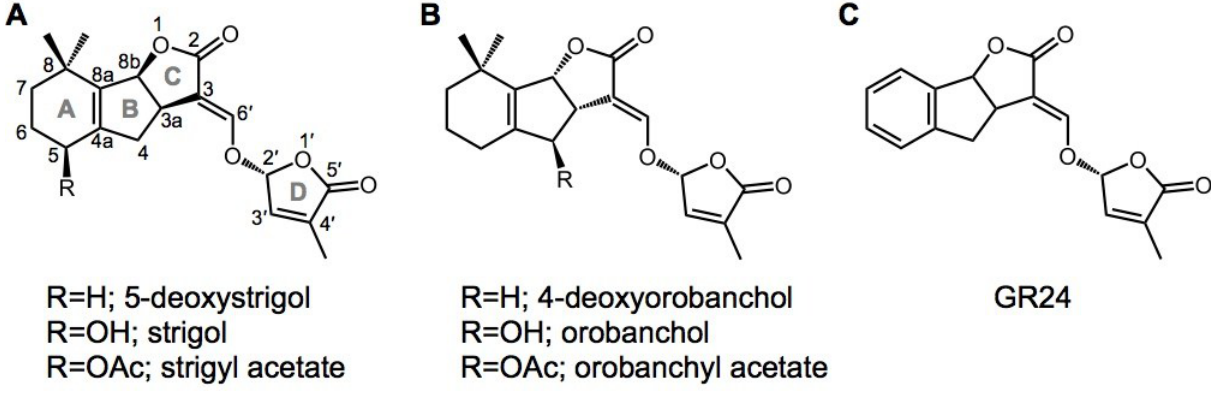
Figure 1. Chemical structures of strigolactones (SLs) and the karrikin (KAR). Natural SLs of ( A ) the strigol type and ( B ) the orobanchol type are shown as representative SLs that have been identified from root exudates of various plant species; ( C ) the synthetic SL analog GR24 is widely used to evaluate the effects of